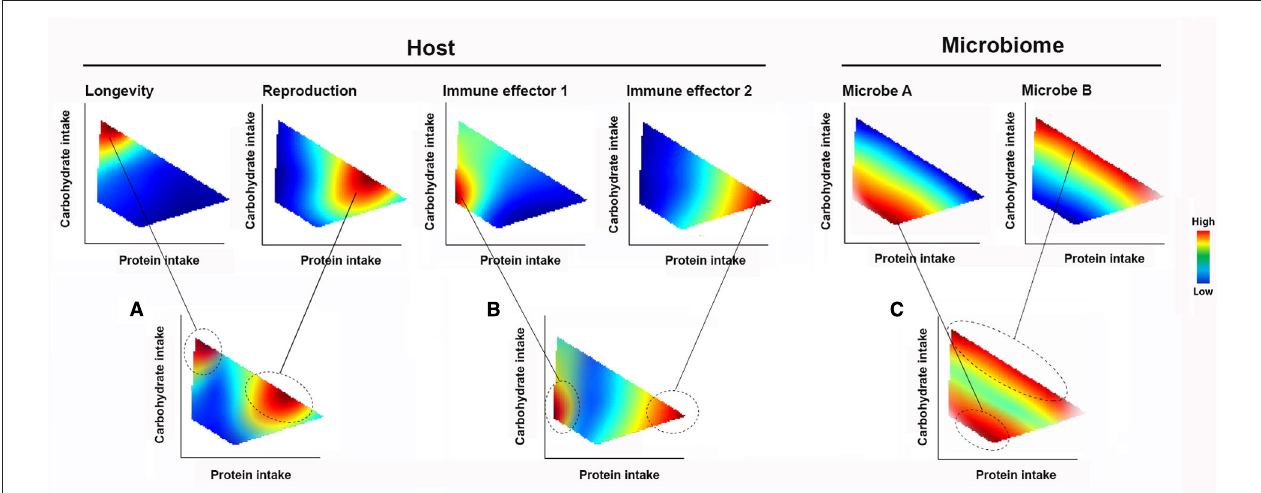
FIGURE 2 | The Geometric Framework of nutritional ecology (GF). Complex nutrient environment is delineated into dimensions (for illustrative purpose, only two dimensions, proteins and carbohydrate intakes are shown). The performance responses of holobiont components to nutrient intake are displayed as heatmap landscapes, with the strength of response indicated by a color code (warmer colors show strongest responses). Changes in nutrient intake allow a host navigating the trade-off spectrum in the nutrient environment. Animal (A) longevity, reproduction and (B) immune effector responses are all dependent on the balance of nutrient intake. The same tradeoffs also apply to (C) different members of the microbiome. Feeding behavior can be selected both in total amount of calories and/or specific amount of nutrient